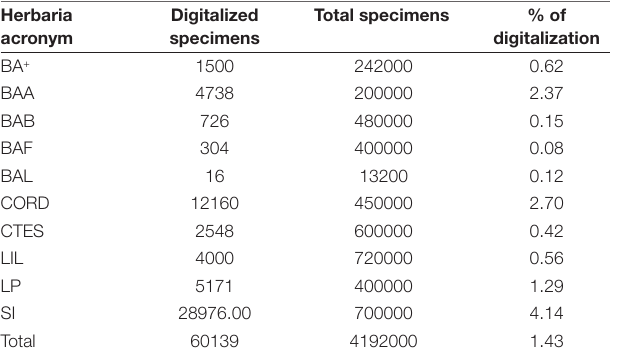
TABLE 3 | Digitalization status of Argentine Vascular Plant collections. Herbaria acronym